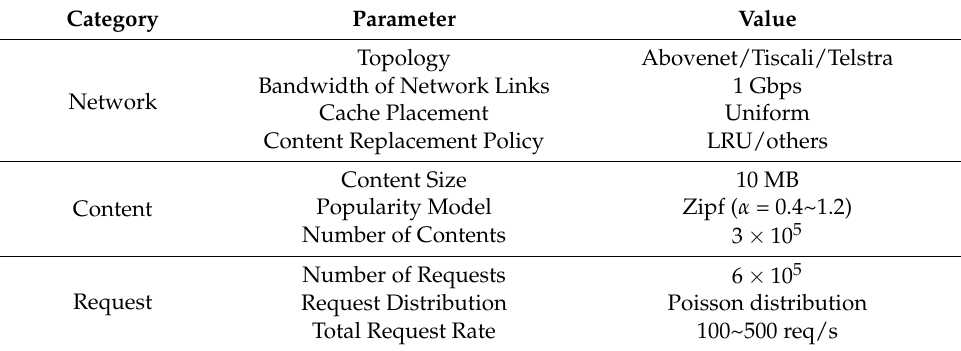
Table 2. Experiment